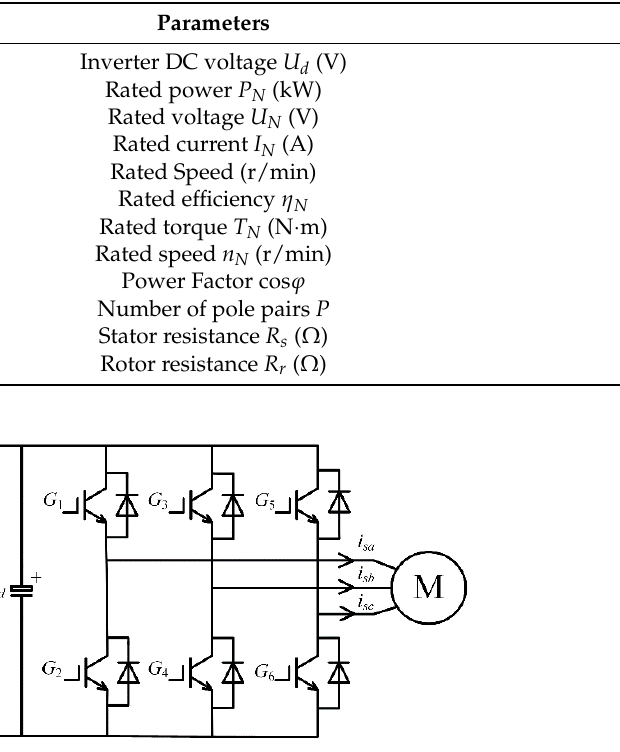
Figure 5. Main circuit topology diagram of the traction motor.